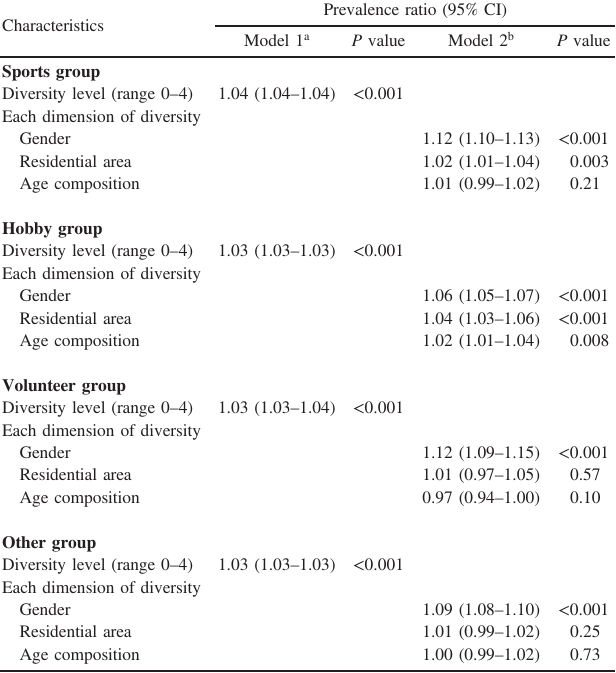
Table 2. Combined prevalence ratios and 95% con fi dence intervals for better self-rated health estimated by Poisson regression and robust variance with multiply